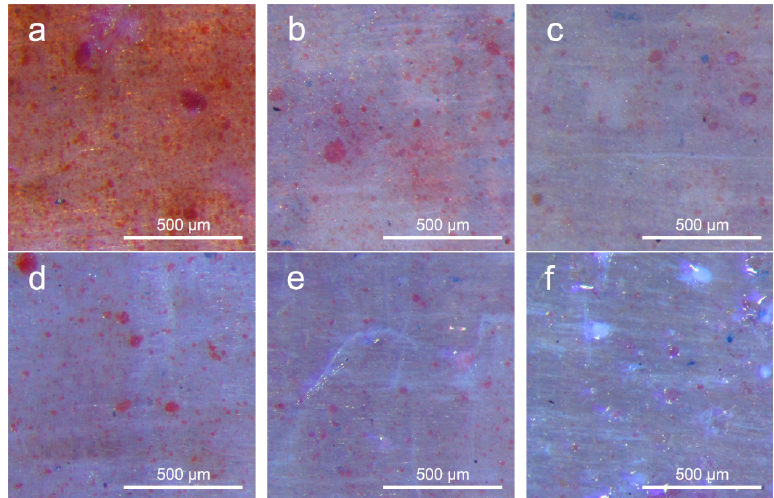
Figure 2. ML grains observed through the stereomicroscope under UV-light illumination: P4 at ( a ) t = 0 h, ( b ) t = 240 h, and ( c ) t = 520 h; P7 at ( d ) t = 0 h, ( e ) t = 240 h. and ( f ) t = 520 h. All areas refer to three coats of the lake-containing layer (OCV or AC).